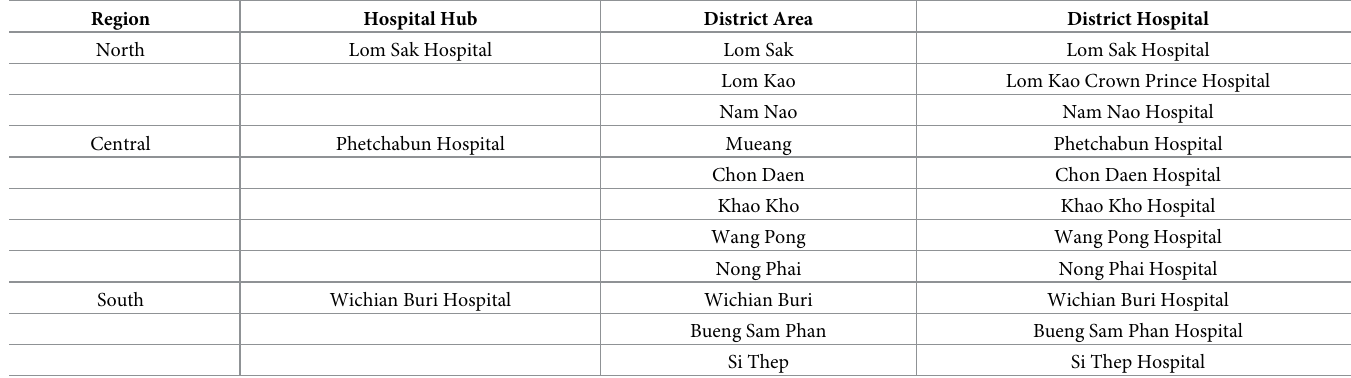
Table 1. Regional hub and district hospitals in Phetchabun involved in the RDT and qualitative HCV RNA testing. Region